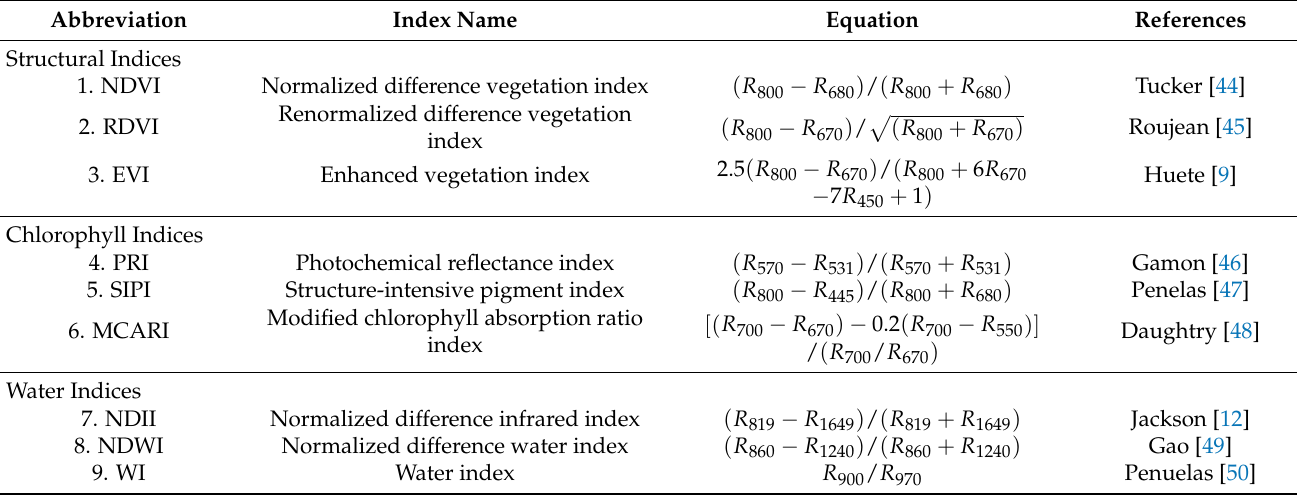
Table 3. Vegetation indices used in this